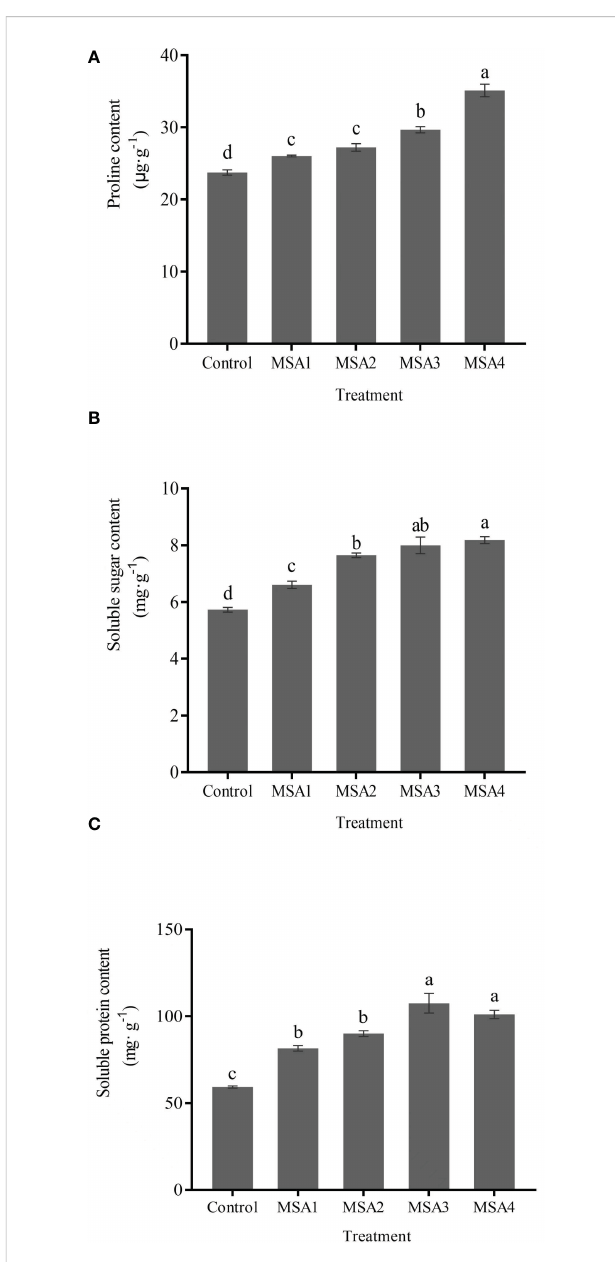
FIGURE 2 Changes in the osmoregulation substances contents of Trollius chinensis leaves upon saline-alkaline stress. (A) , Proline content; (B) , Soluble sugar content; (C) , Soluble protein